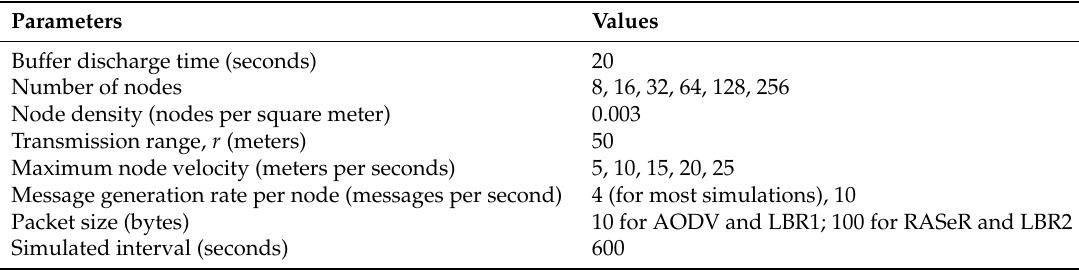
Table 1. Simulation